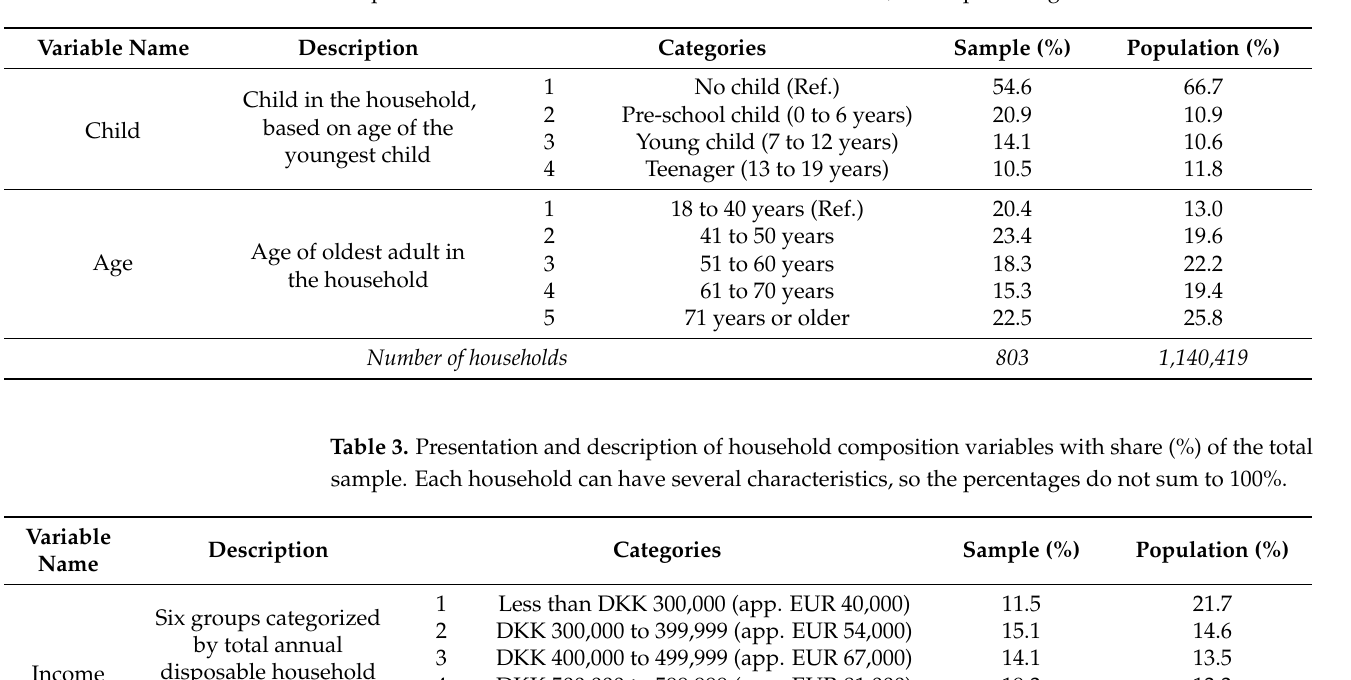
Table 2. Presentation and description of household composition variables with share (%) of the total sample. Each household can have several characteristics, so the percentages do not sum to 100%.